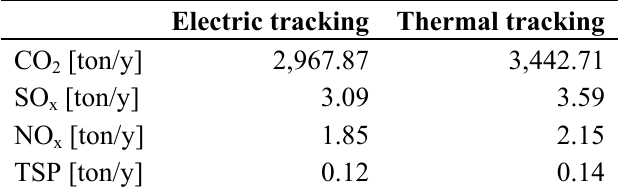
Table 5. Global emission savings.